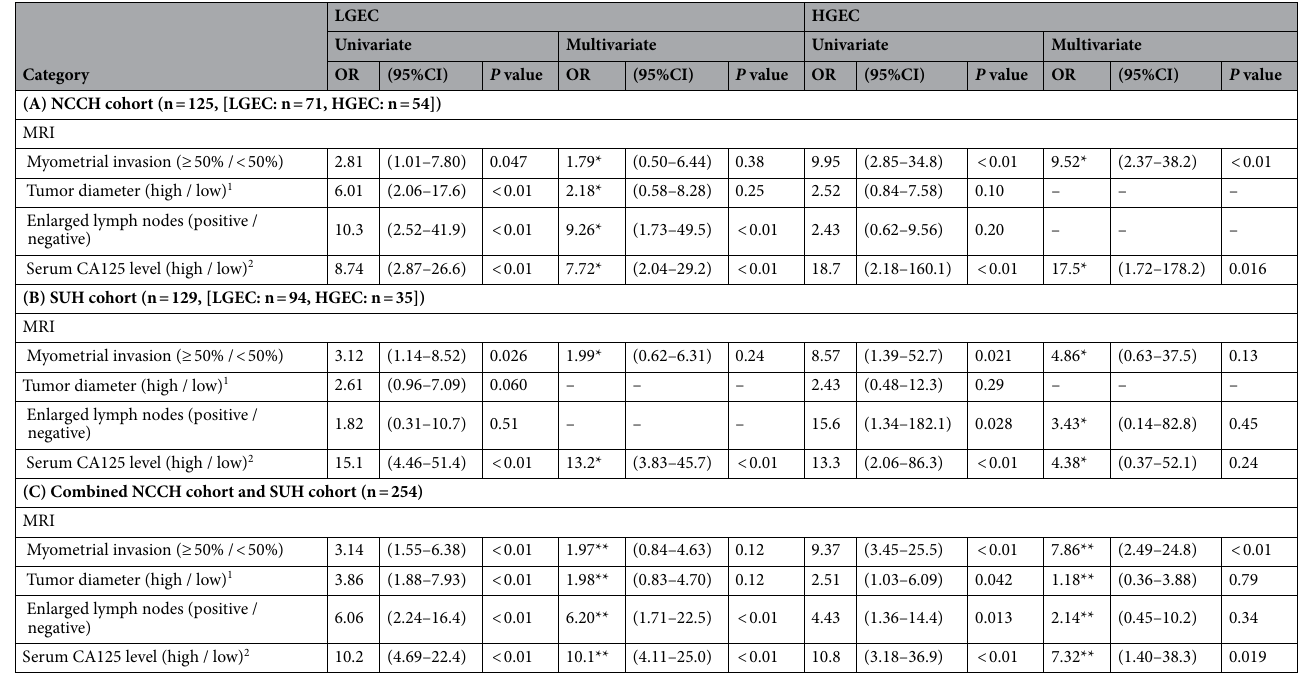
Table 4. Association between lymph node metastasis and preoperative clinical risk factors according to the biopsy histological grade. LGEC Low-grade endometrial cancer, HGEC High-grade endometrial cancer, OR Odds ratio, CI Confidence interval, NCCH National Cancer Center Hospital, MRI Magnetic resonance imaging, CA125 Cancer antigen 125, SUH Showa University Hospital. *Adjusted by statistically significant variables in univariate analysis. **Adjusted by cohort and statistically significant variables in univariate analysis. 1 High level, > 47 mm. 2 High level, > 52.3U/mL(unmenopause), > 48U/mL(menopause).